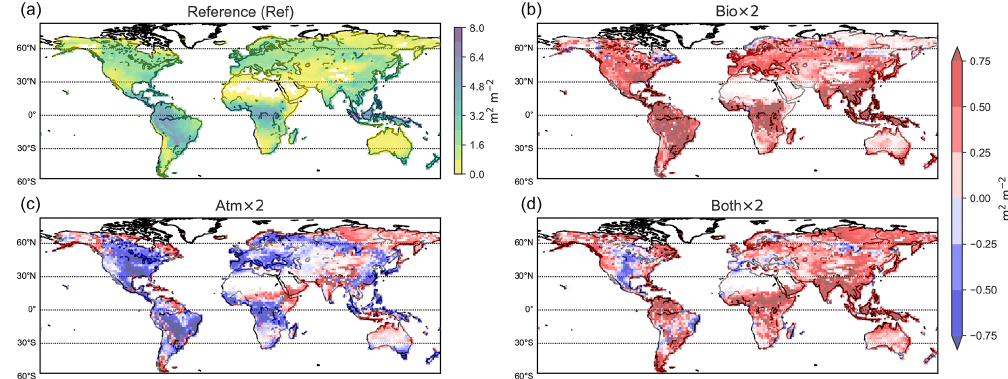
Figure 11. Geographic distribution of the LAI for the reference study (Ref) and difference plots. Bio × 2 − Ref (b) , Atm × 2 − Ref (c) and Both × 2 − Ref (d) are